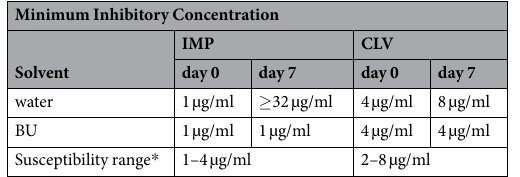
Table 1. Minimal inhibitory concentrations of imipenem and clavulanic acid for Escherichia coli ATCC-35218 and Pseudomonas aeruginosa ATCC-27853. Results are expressed as median of three experimental replicates. The breakpoints ranges established by the Clinical Laboratory Standard Institute (CLSI) are also indicated. * Derived from CLSI